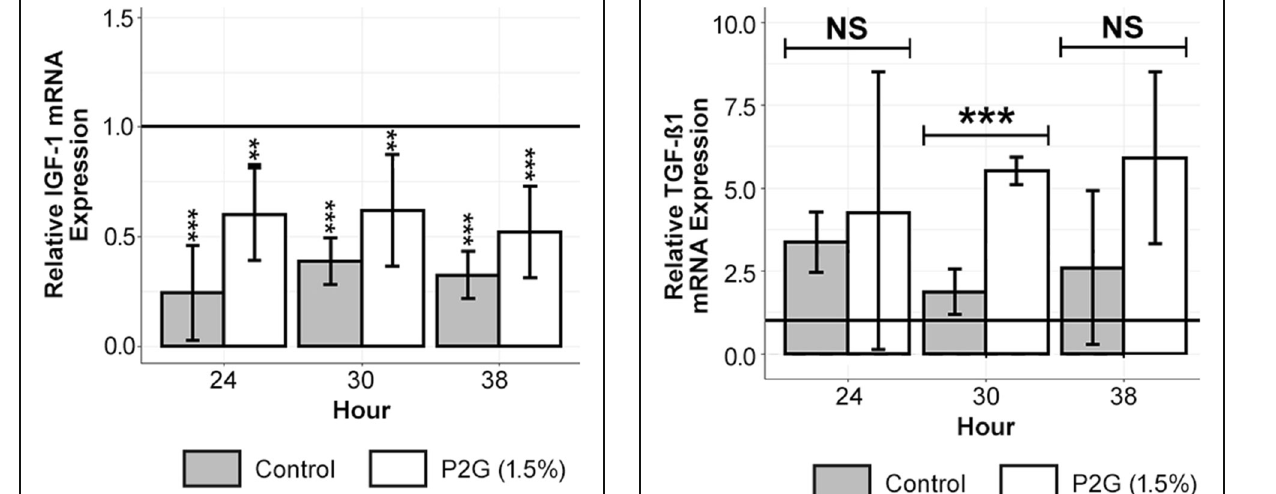
= 0.0576) and 38 (1.61-fold increase, p = 0.0977).